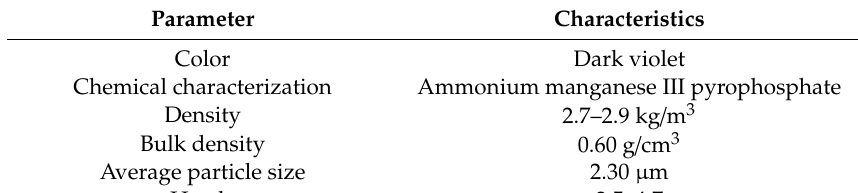
Table 1. Typical characteristics of MnNH 4 P 2 O 7 pigment [26].